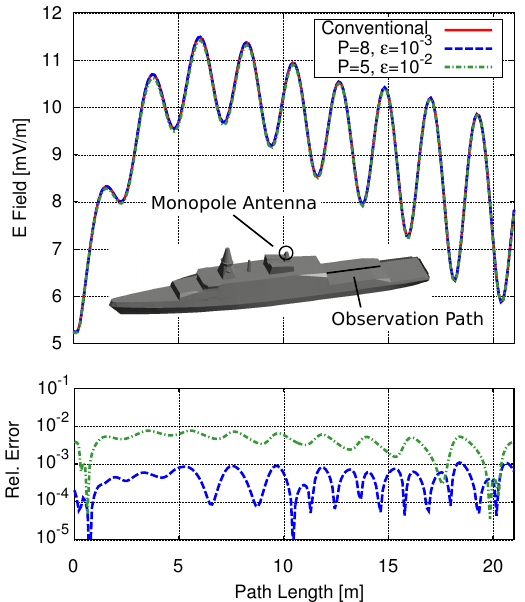
Figure 7: Top: Max. magnitude of E field along the indi- cated observation path (length 21 m, 1 m above the deck), computed with a conventional FMM approach and the pro- posed compression for aggregation matrices. P : Maximum order of spherical harmonics. (cid:15) : Accuracy of compression with TSVD. Bottom: Relative error of E field (referring to the conventional approach).